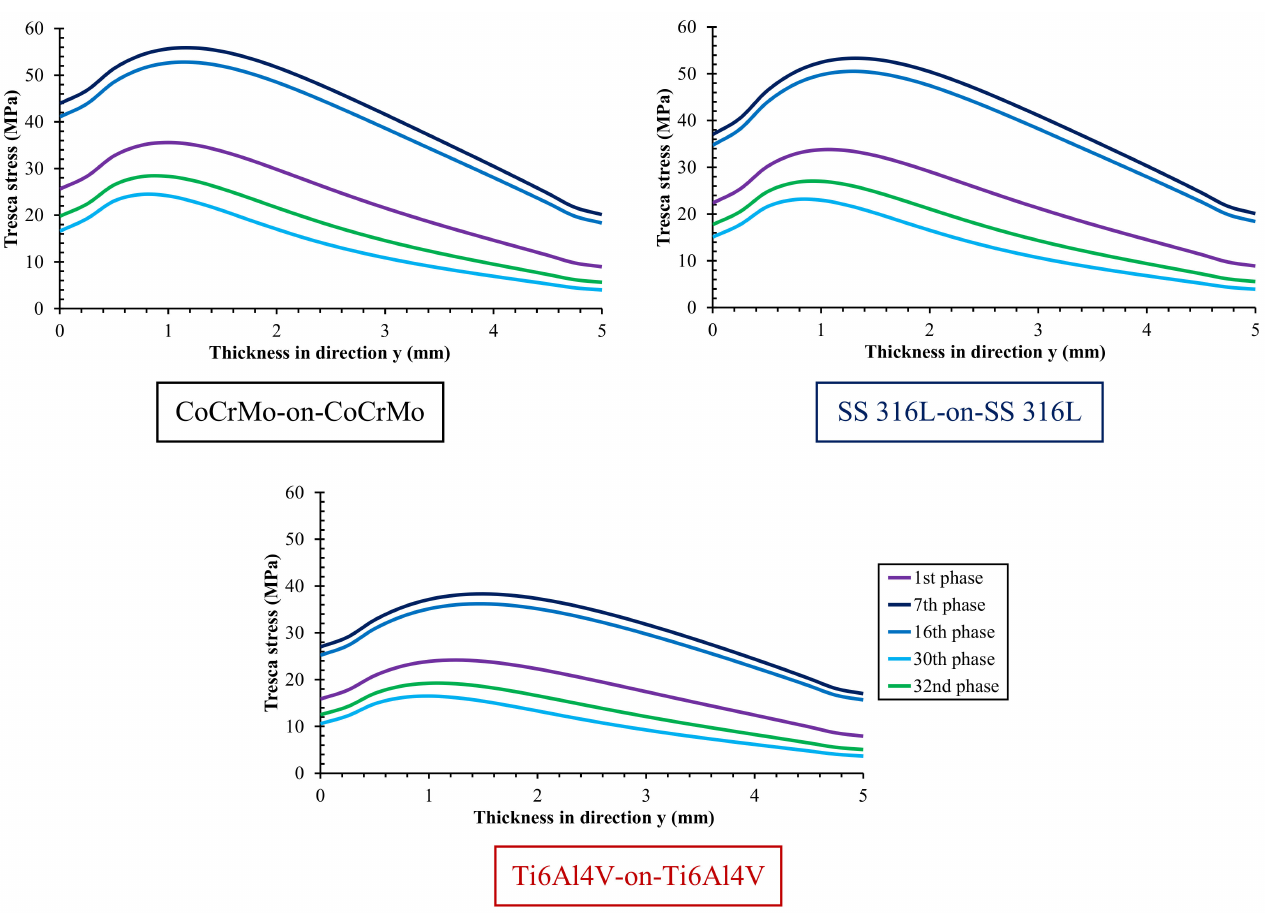
Figure 7. Tresca stress profile as a function of acetabular cup thickness for different metal-on-metal bearing materials at selected